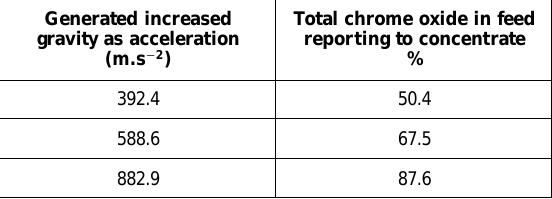
Fig. 5 % Mass of mixed particles Table 1 Percentage chrome oxide fed to a Knelson concentrator (CVD) reporting to